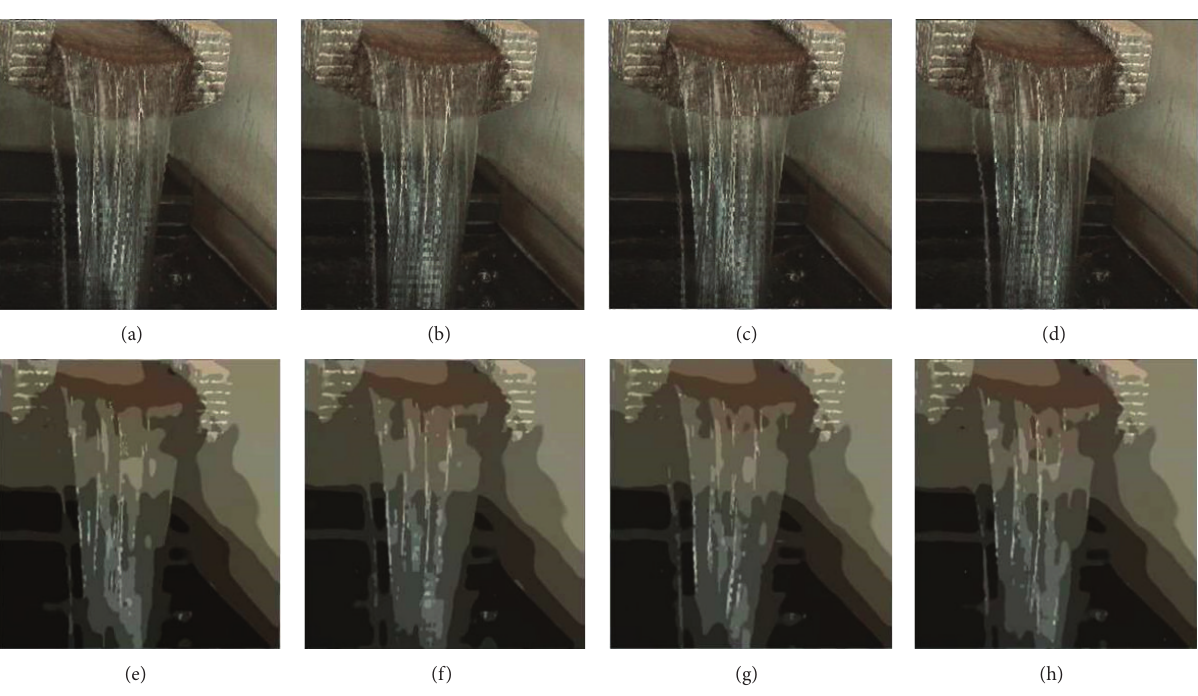
Figure 3: Video texture filter of blowing